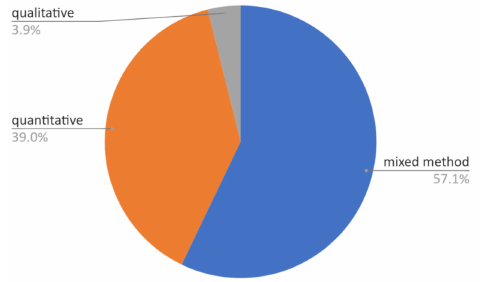
Figure 10. Research design of